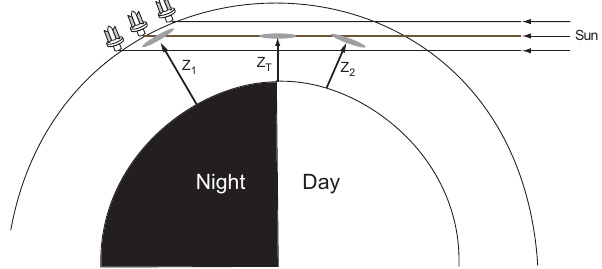
Fig. 3. This figure shows the approximate geometry of the SAGE II observations and demonstrates the different ways in which clouds can manifest themselves in line-of-sight observations. For the center ray in the figure above, clouds at 3 different altitudes ( Z 1 , Z 2 , and Z T ) are all observed for a ray at a single tangent altitude, Z T .